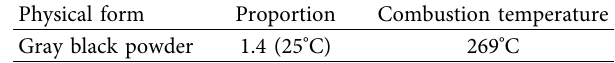
Table 3: Technical indexes of stabilizer.